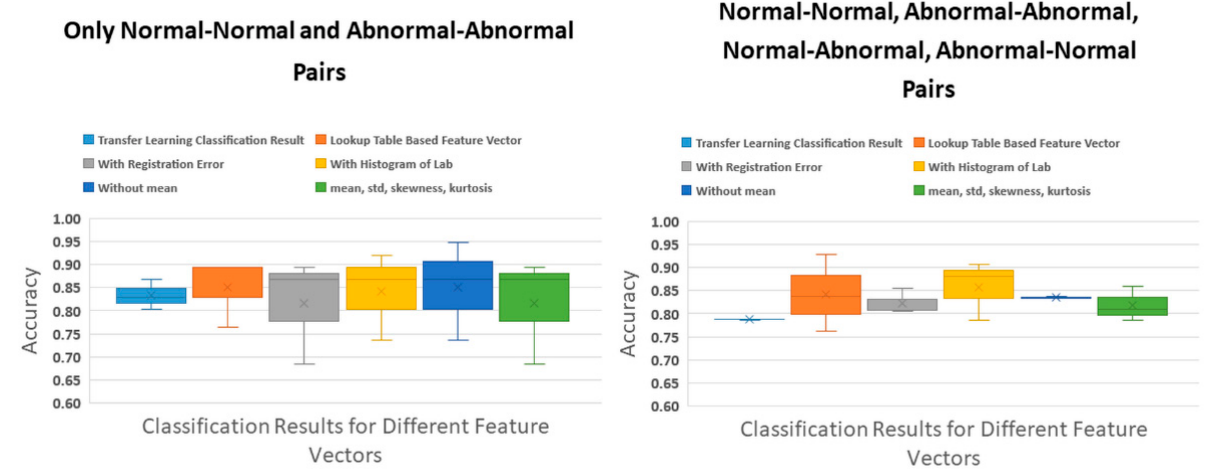
Figure 4. Results of Three-Fold Classification Accuracies for Different Feature Vectors Only Normal-Normal and Abnormal-Abnormal Pairs and after added Abnormal-Normal/Normal-Abnormal Pairs.